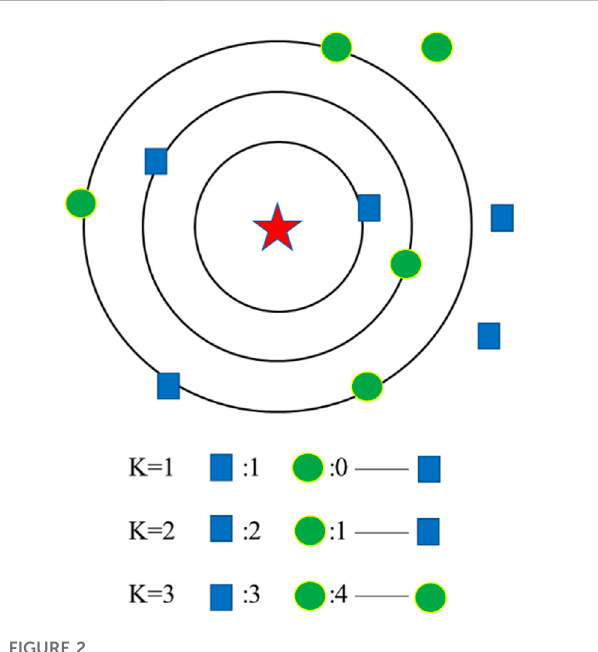
FIGURE 2 Schematic diagram of the KNN